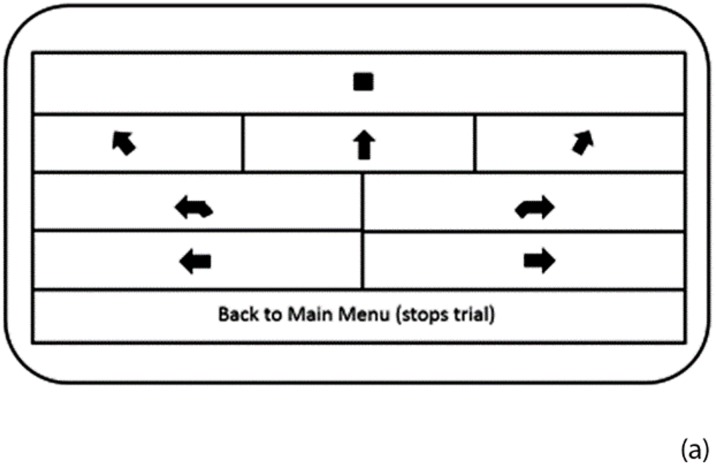
Custom android application provides audible commands for the Audible Mobility Feedback System.Front view of the custom android application showing commands implemented as buttons on a touchscreen. The outputs were audible commands delivered to the subject via bone conduction headphones.